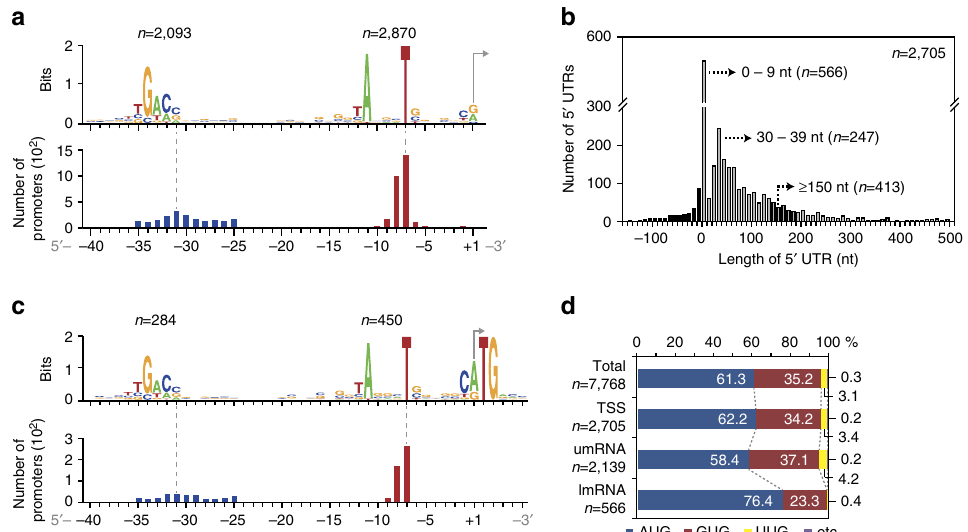
Figure 2 | Genome-scale analysis of promoter sequences. ( a ) (cid:2) 10 motif (5 0 -TANNNT) and (cid:2) 35 motif (5 0 -NTGACC) were identified relative to TSS position ( þ 1). The analysis showed three identical positions to the (cid:2) 10 motif of the E. coli promoter (that is, 5 0 -TATAAT) recognized by its housekeeping sigma factor ( s 70 ). It has been suggested that the well-conserved TTG motif commonly found in the 5 0 half of the E. coli (cid:2) 35 motif (that is, TTGACA) is located in the 5 0 half of the S. coelicolor (cid:2) 35 motif 38 . Although S. coelicolor has a lower level of conservation of the TTG motif this analysis clearly identifies the motif at the same position. The bottom panel shows the position distribution of the (cid:2) 10 motif (red) and (cid:2) 35 motif (blue) relative to the TSS. ( b ) Distribution of 5 0 -UTR lengths reveals a dual peak distribution at 30–39nt and 0–9nt; the latter group are considered to produce leaderless mRNAs (lmRNAs). ( c ) The same (cid:2) 10 and (cid:2) 35 consensus sequences are observed upstream of lmRNAs. The motif around the TSS ( þ 1) is also indicated. The third motif found at the þ 1 position clearly shows the translation initiation codon, indicating that lmRNAs are translated without 5 0 -UTR-mediated recognition. ( d ) Start codon usage of all open reading frames (ORFs; Total), primary TSS-identified ORFs (TSS), 5 0 -UTR-associated genes (umRNA) and leaderless genes